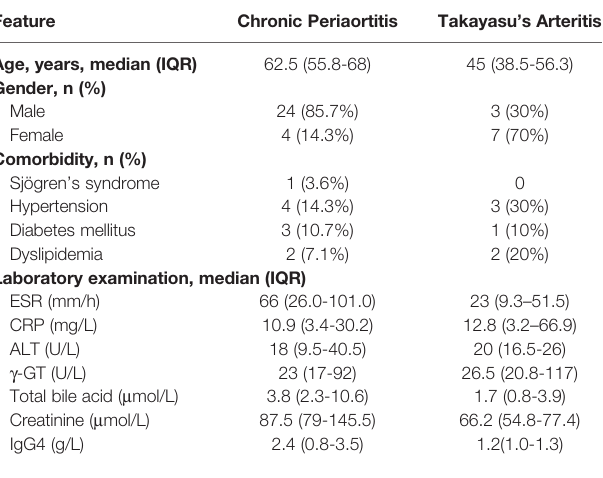
TABLE 1 | Demographics, clinical characteristics of CP and TA patients.